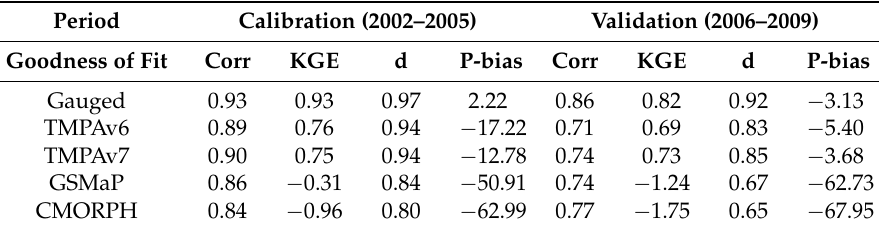
Table 2. Performance statistics of the PRMS model for the calibration and validation periods.